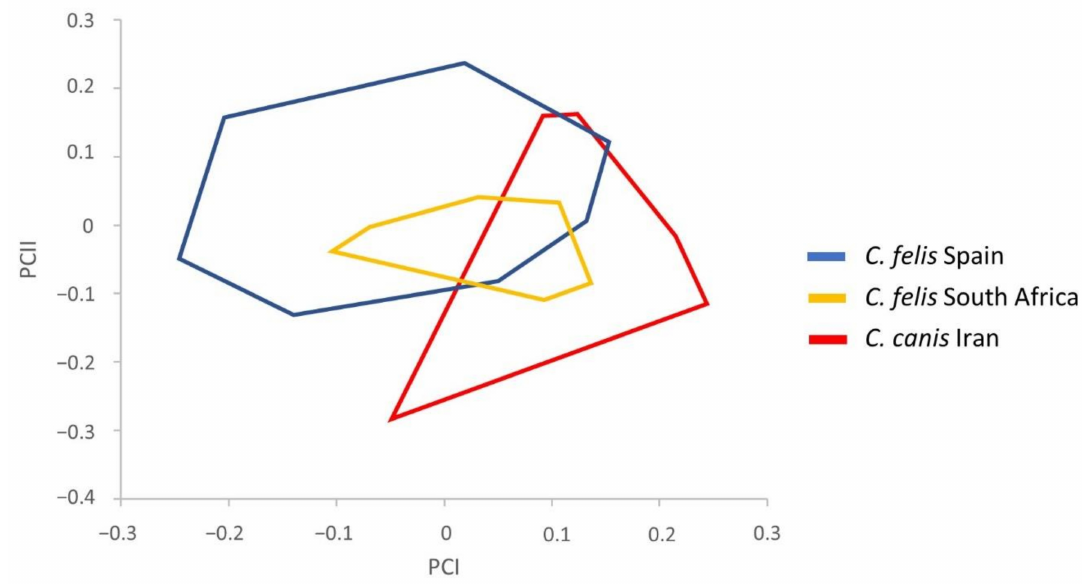
Figure 3. Factor map corresponding to Ctenocephalides spp. female adults from Spain, South Africa, and Iran. Samples are projected onto the first and second principal components: PCI (55%) and PCII (28%). Each group is represented by its